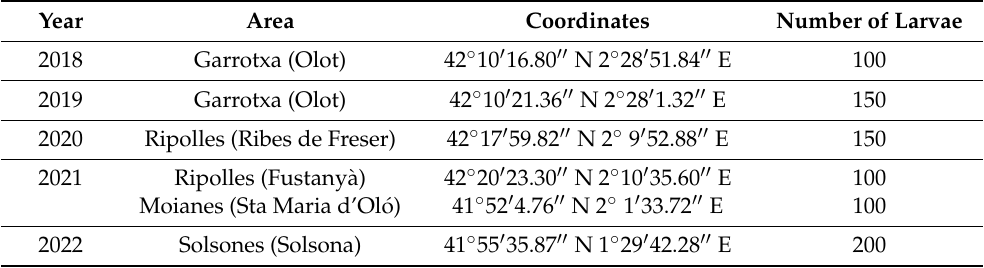
Table 2. Collected Cydalima perspectalis larvae in boxwoods of different regions of Catalonia and across different